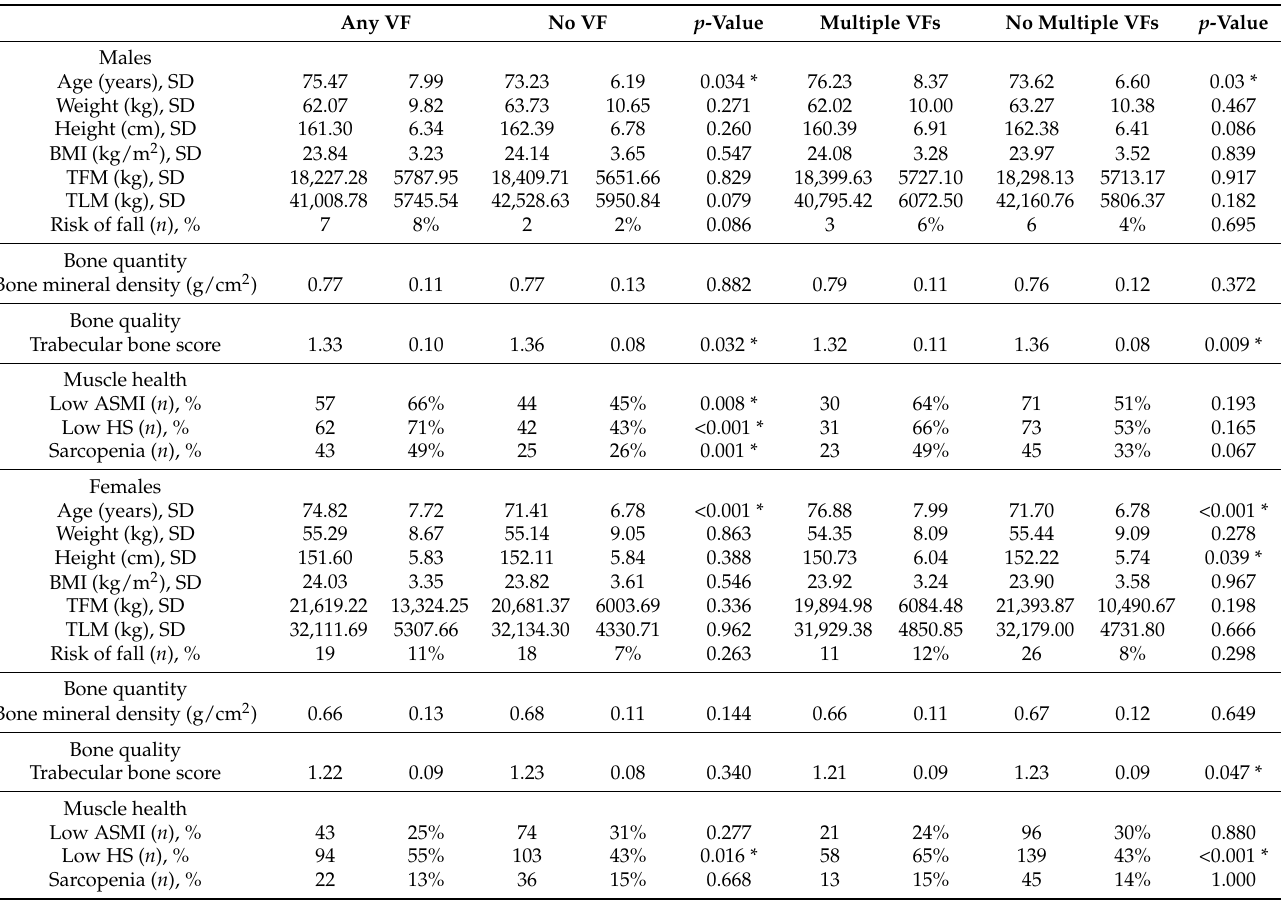
Table 3. Comparison between participants with and without vertebral compression fractures